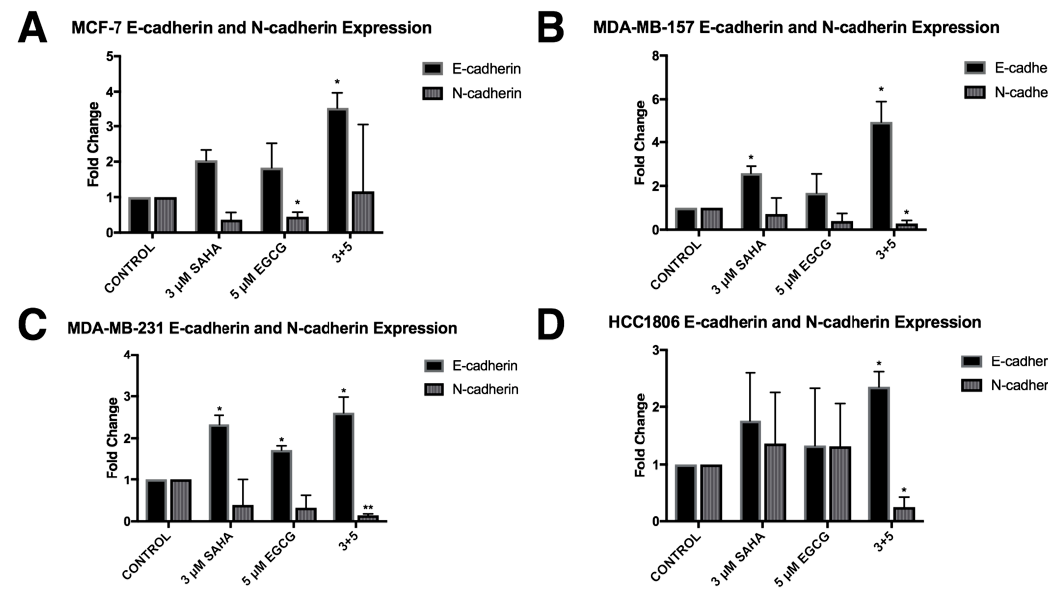
Figure 13. The expression of E-cadherin was induced with SAHA and EGCG while the expression of N-cadherin was reduced. ( A ) MCF-7 cells were treated for 72 h with the indicated compounds. qRT-PCR was completed using E-cadherin or N-cadherin primers. N-cadherin was significantly reduced by EGCG alone. ( B – D ) The same was completed in MDA-MB-157, MDA-MB-231, and HCC1806 cell lines ( n = 3). Error bars represent standard error of the mean (SEM); * p < 0.05, ** p < 0.01. Cancers 2018 , 10 , x FOR PEER REVIEW